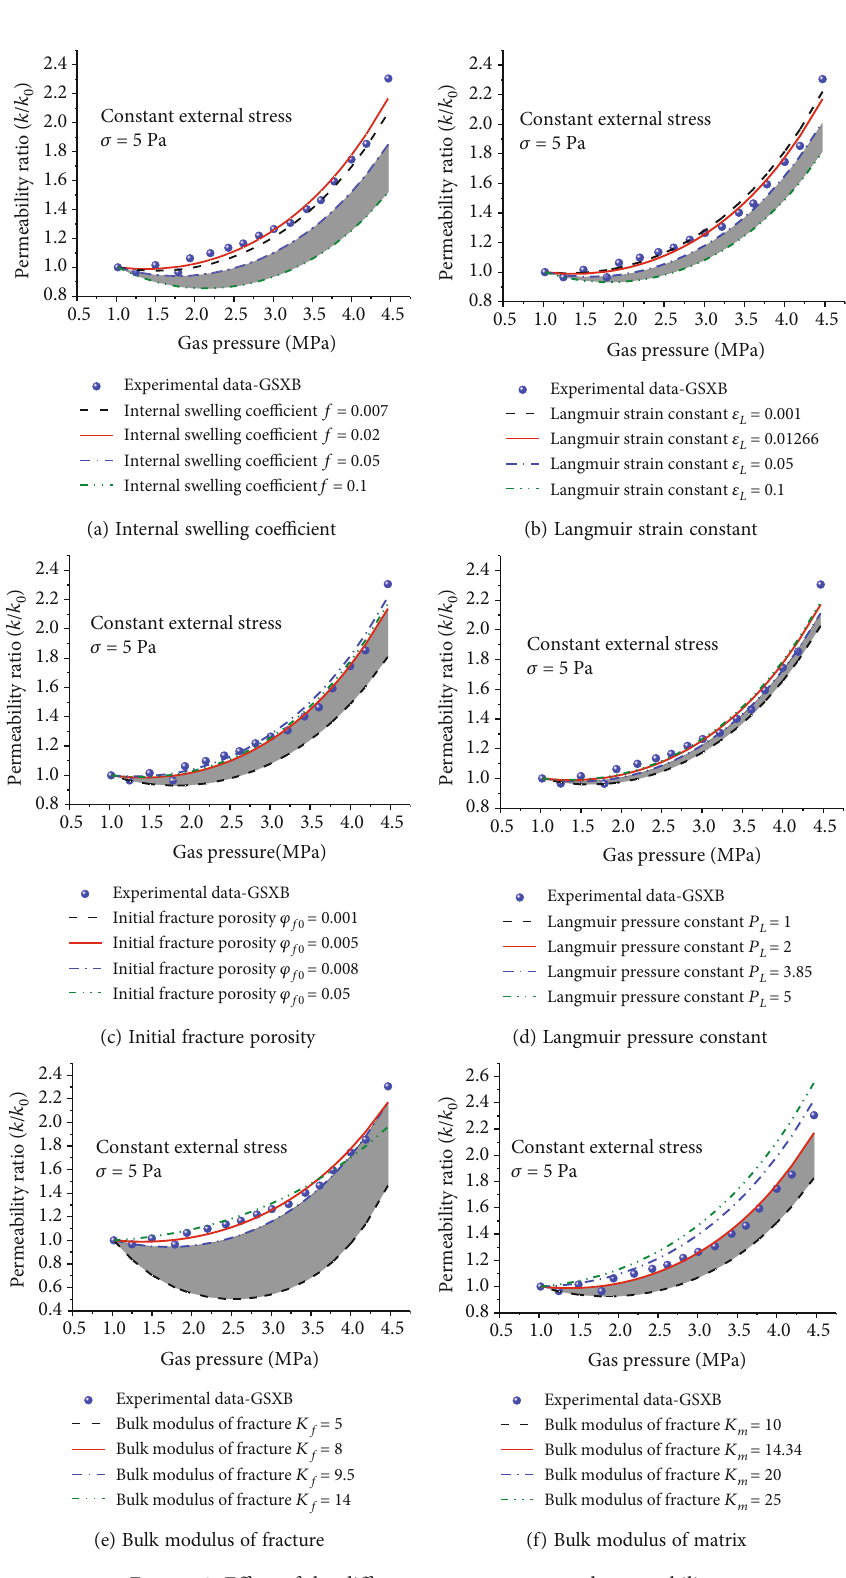
Figure 8: E ff ect of the di ff erent parameters on coal